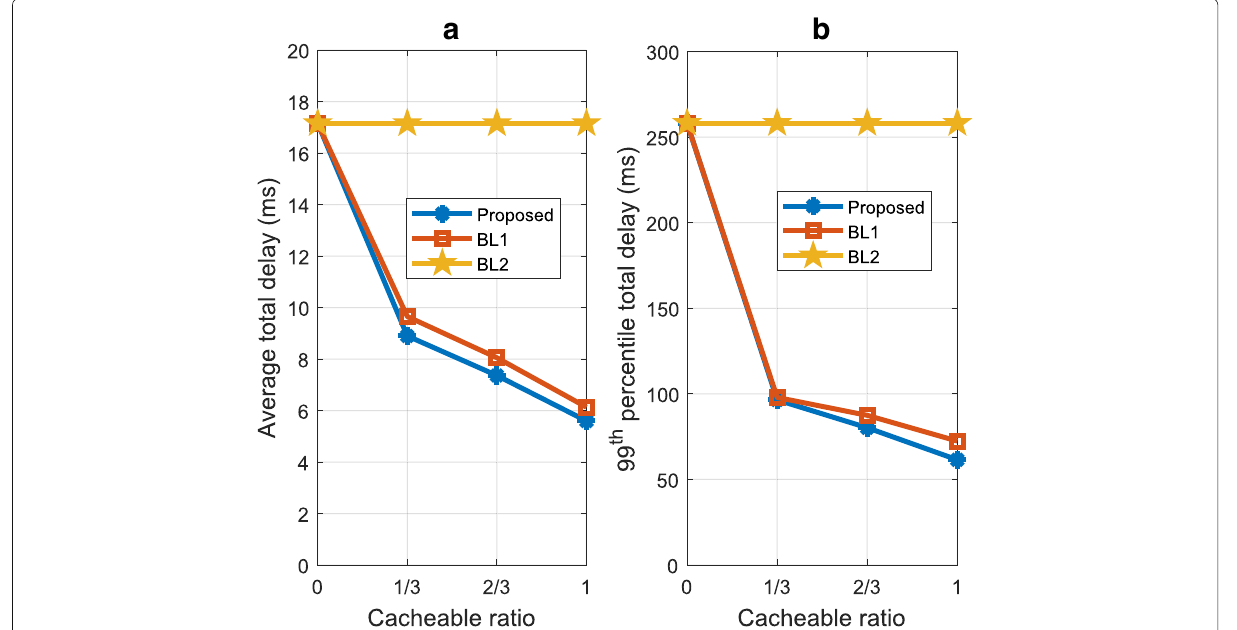
Fig. 6 The delay performance vs. cacheable ratio. a The average delay and b the 99th percentile delay performance for different ratios of cacheable tasks, with E = 30 cloudlets, UN density U / E = 3, and a storage size s e of